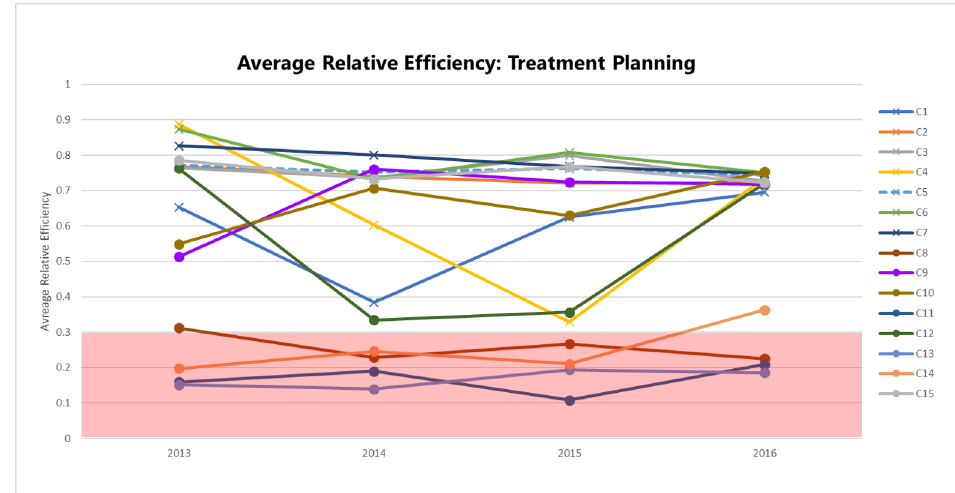
Figure 3. Mean bias-corrected planning efficiency scores.